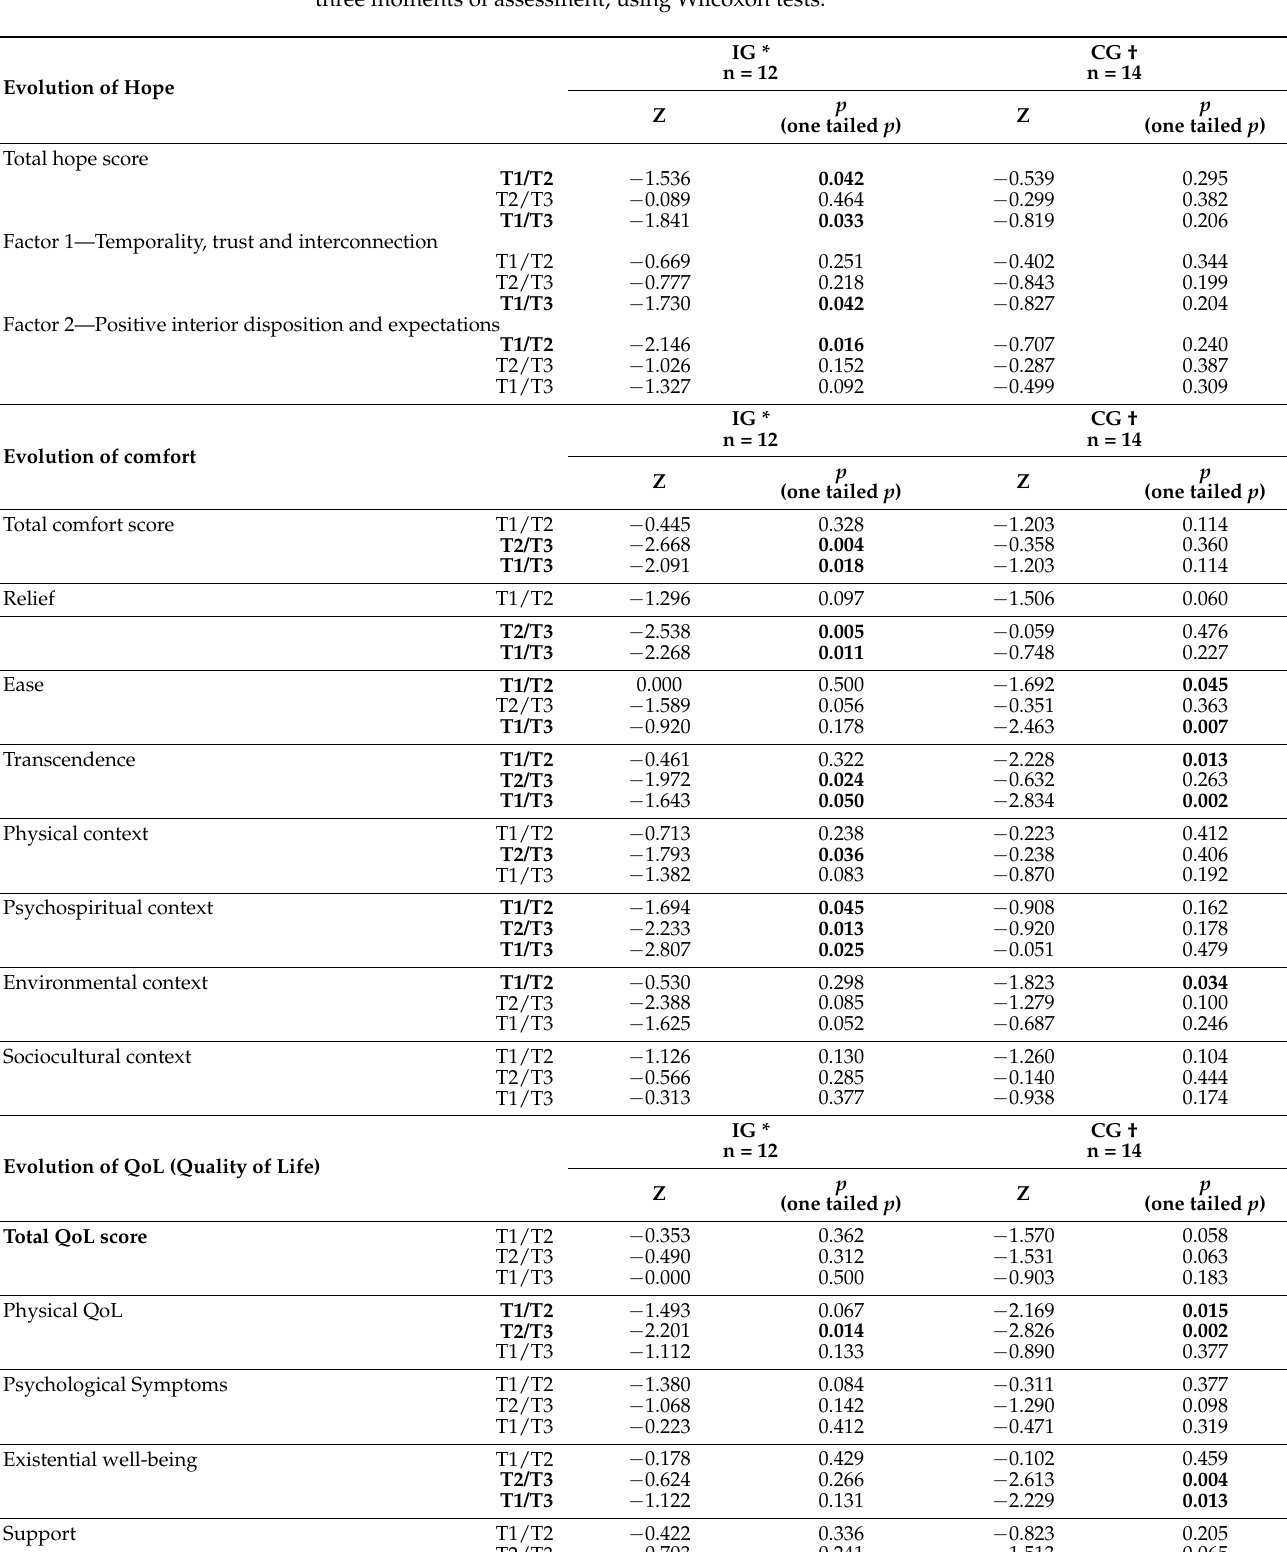
Table 4. Evolution of the total hope, comfort, QoL and its dimensions, in both groups, comparing the three moments of assessment, using Wilcoxon